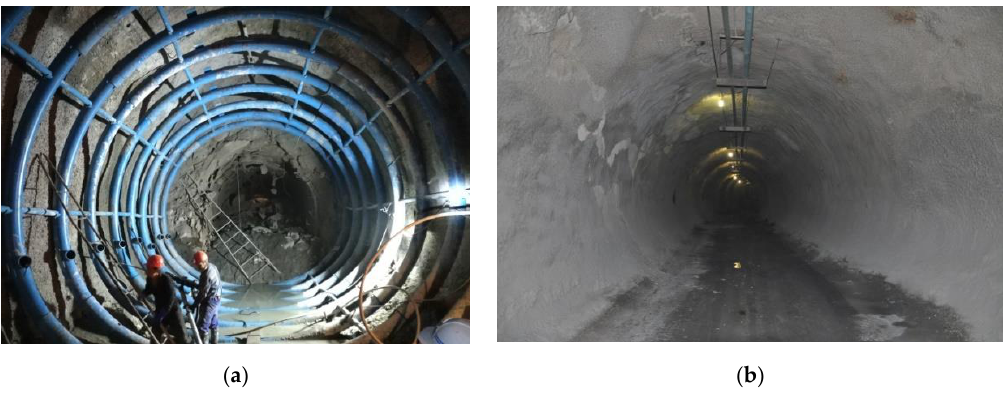
Figure 23. Schematic of the test roadway before and after the novel support scheme: ( a ) Construction period, ( b ) Current situation.